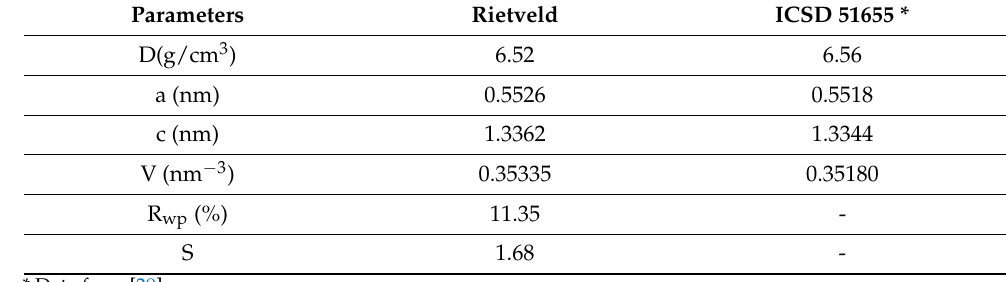
Table 2. Crystallographic parameters of La 0.8 Sr 0.2 MnO 3 particles. Parameters